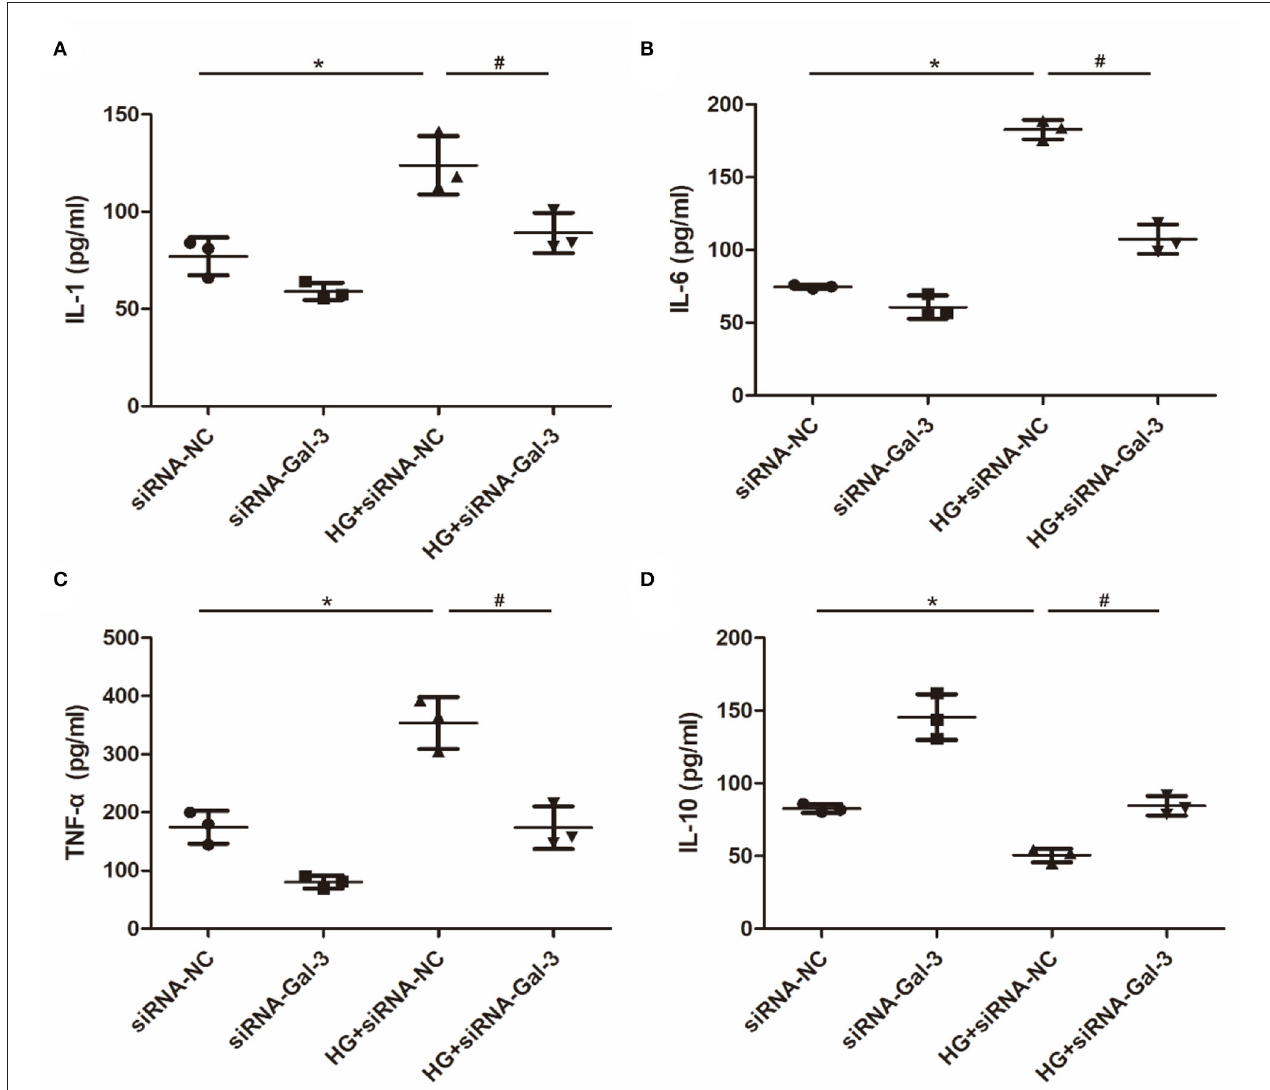
FIGURE 7 | Gal-3 knockdown regulated HG (high glucose)-induced cytokines expression in macrophages (A–D) ELISA analysis of IL-1, IL-6, TNF- α and IL-10. Data are shown as mean ± SD. n = 3, * P < 0.05 vs. siRNA-NC; # P < 0.05 vs. HG + siRNA-NC.